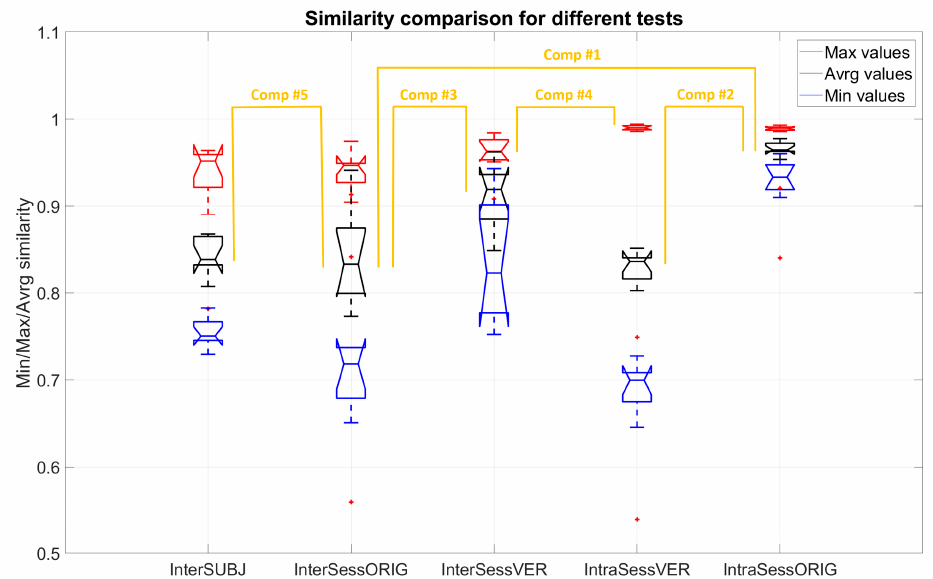
Figure 16. Comparison of muscle synergy similarity with di ff erent analysis approaches: inter-session (InterSessORIG), intra-session with sub-selection (IntraSessORIG), intra- and inter-session with virtual electrode repositioning (IntraSessVER and InterSessVER), and inter-subject (InterSUBJ) for all 10 participants and VAF threshold = 80%. The X axis represents di ff erent tests as described above, and Y axis represents MIN (blue), MAX (red), or AVRG (black) values of similarities. The details of each test are reported in the